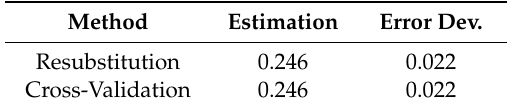
Table 7. Estimation risk for using Instagram (CHAID method).